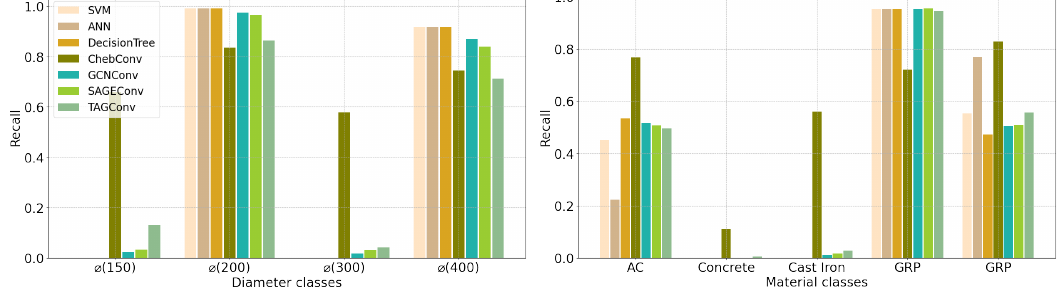
( a ) Diameter prediction: 30% training and 70% test. ( b ) Material prediction: 30% training and 70% test.